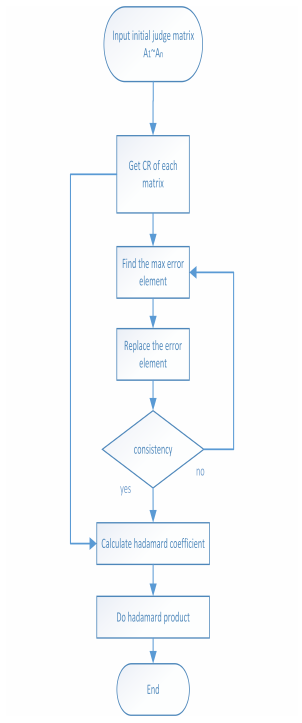
Figure 5. The flow chart of this enhancement